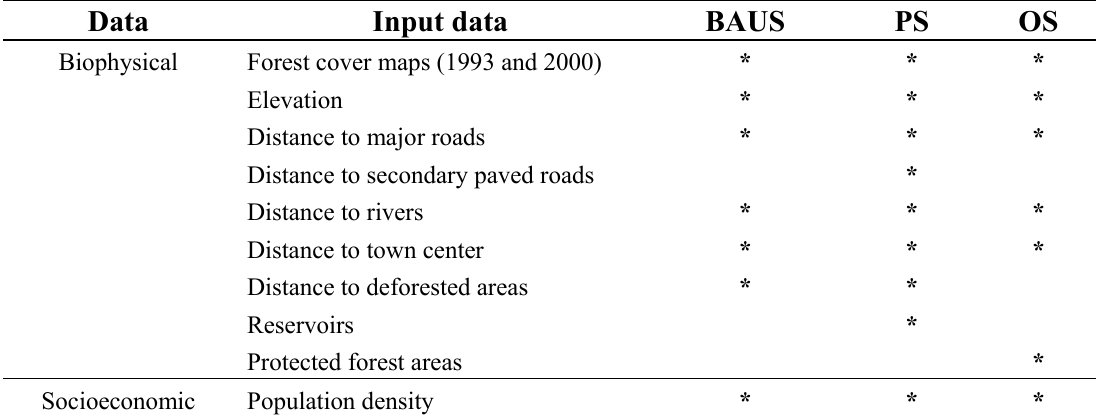
Table 5. Input data for simulating forest cover changes under different